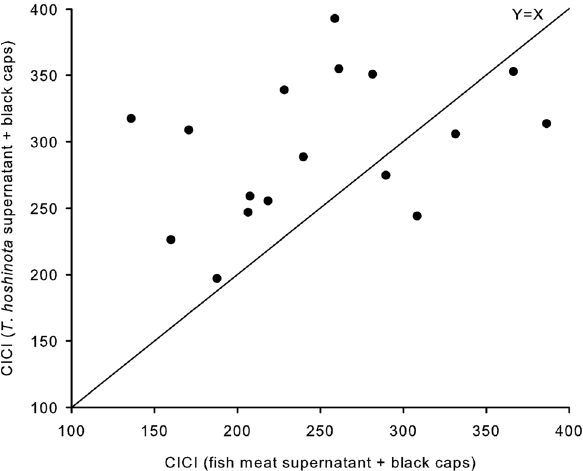
Figure 2. Comparison of color intensity change indices (CICI) between “F + B” and “S + B”. The line in the plot represents Y = X. CICI (S + B) > CICI (F + B) (n = 17, p = 0.028, Wilcoxon Signed Rank Test). F: Fish, B: Black caps, S: Sponge.